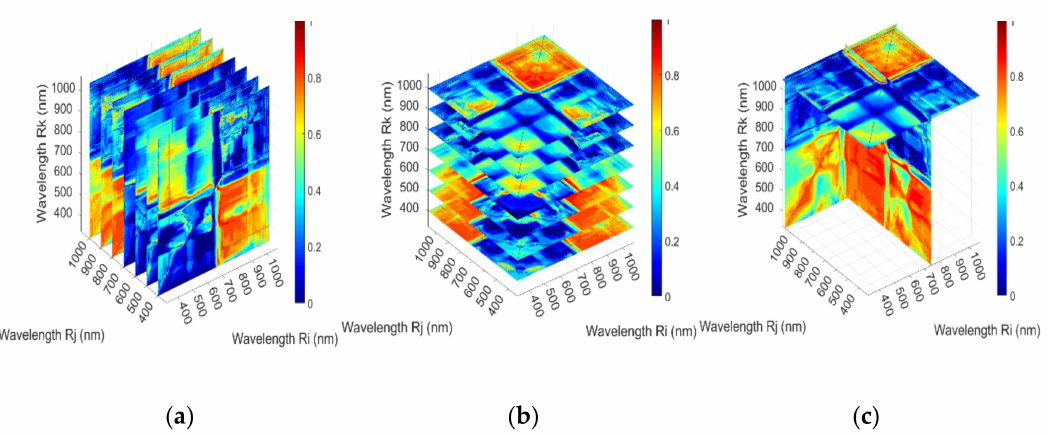
Figure 3. The 3D KI slice map of the ideal sequence and damage level sequence on RIDSI. ( a ) Vertical slice, ( b ) horizontal slice, ( c ) best slice.